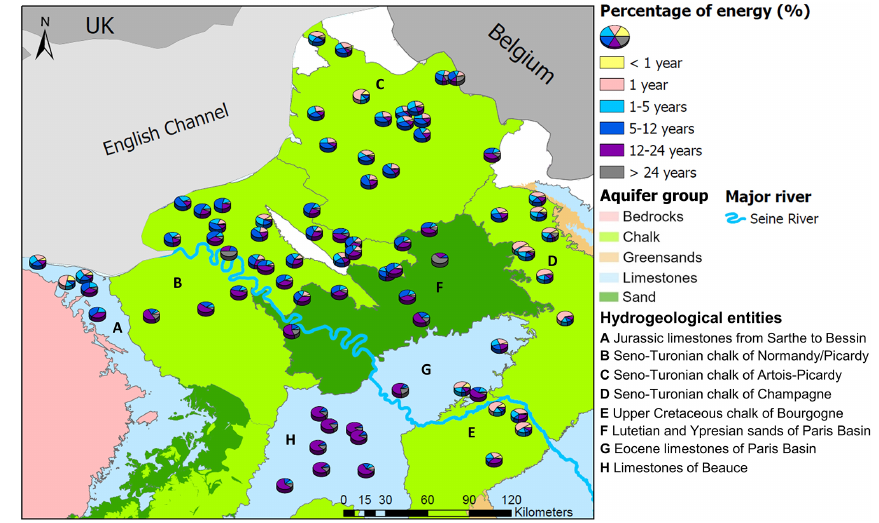
Figure 5. Multi-timescale variability of groundwater levels in the Paris Basin (78 boreholes). Pie charts describe the energy percentage of each timescale of variability reflecting their importance in total groundwater level variations. This energy percentage is derived from the MODWT